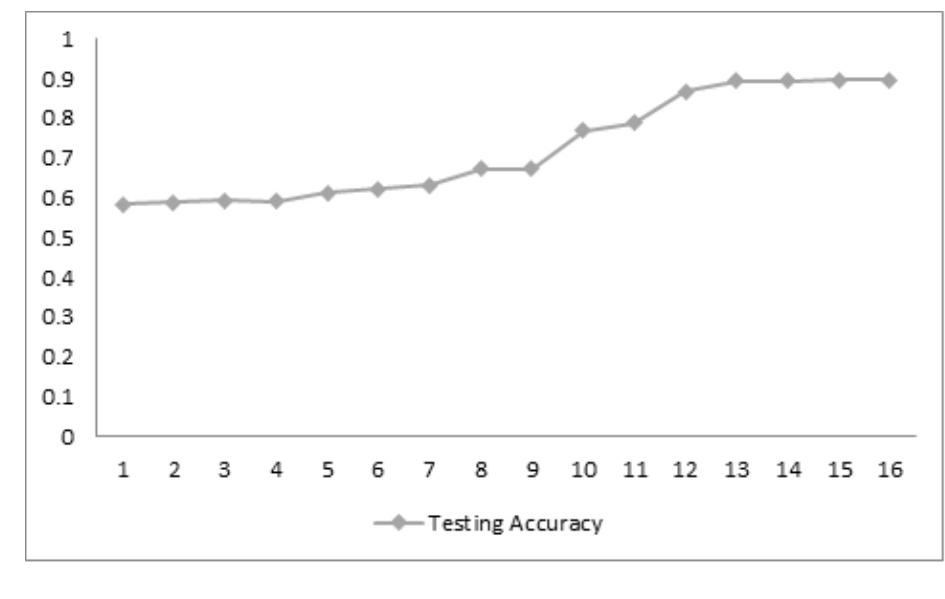
Figure 3. Evaluation of the testing accuracy.